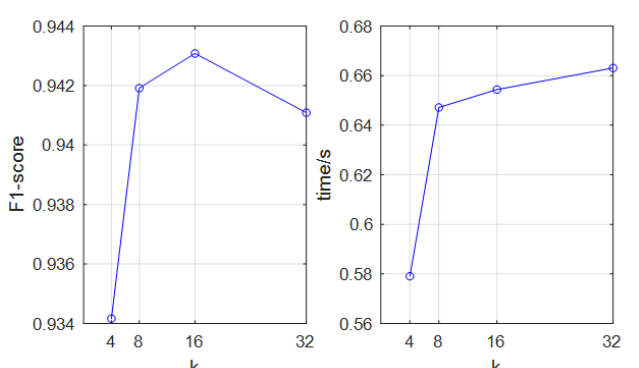
Figure 3. The analysis of k on grand_place_brussels from ChallengeData: Left : the average F1-score; Right : the average running time for each image pair.